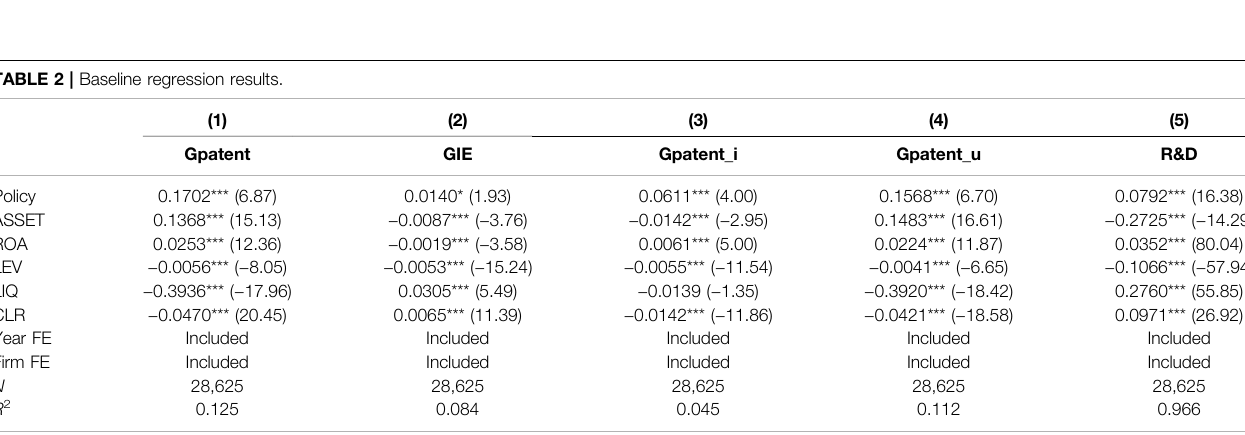
TABLE 2 | Baseline regression